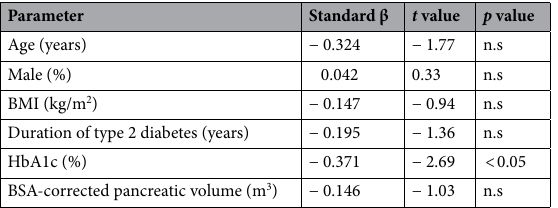
Table 2. Multiple regression analysis about several factors influencing HOMA2-β levels. BMI body mass index, BSA body surface area.